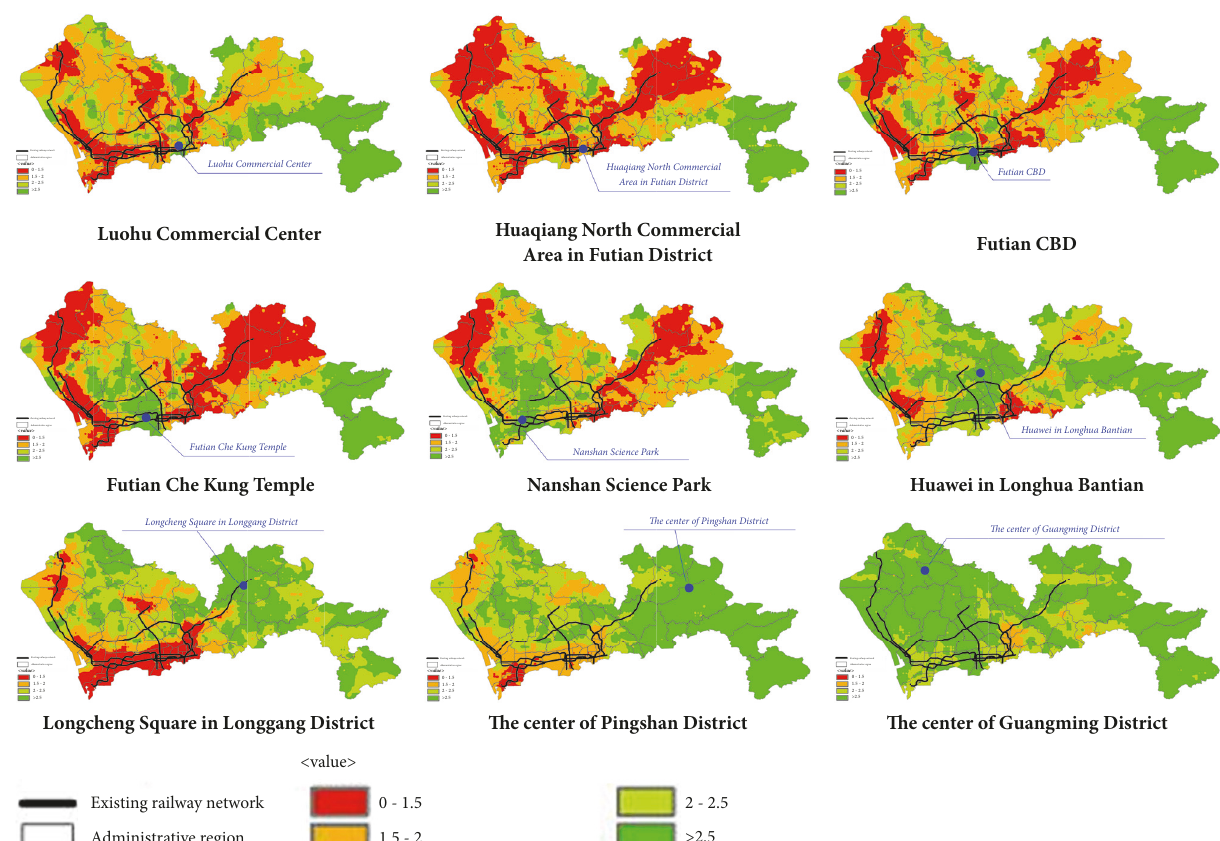
Figure 8: Shenzhen key areas public transport-private cars travelling time ratio.